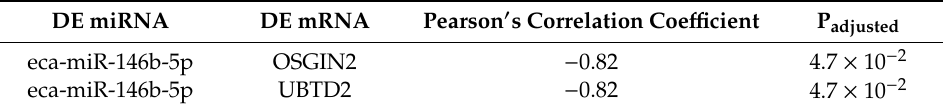
Table 13. Significant negatively correlated miRNA–mRNA pairs for the comparison of asthmatic horses in an exacerbated state and asthmatic horses in remission. Pearson’s correlation coe ffi cient and adjusted p -values are